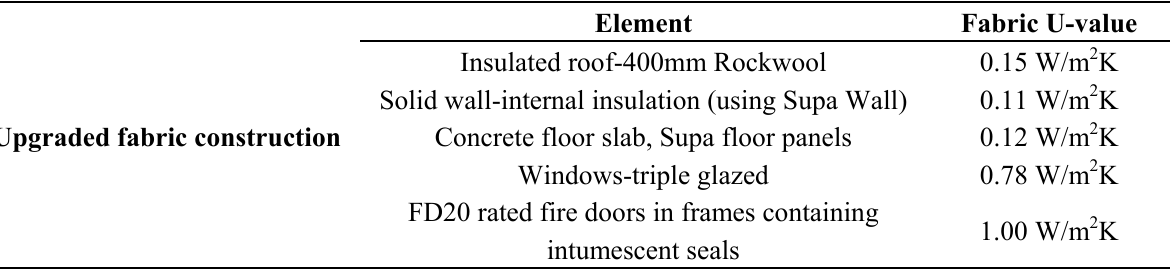
Table 2. Post-refurbishment thermal features of the terraced house